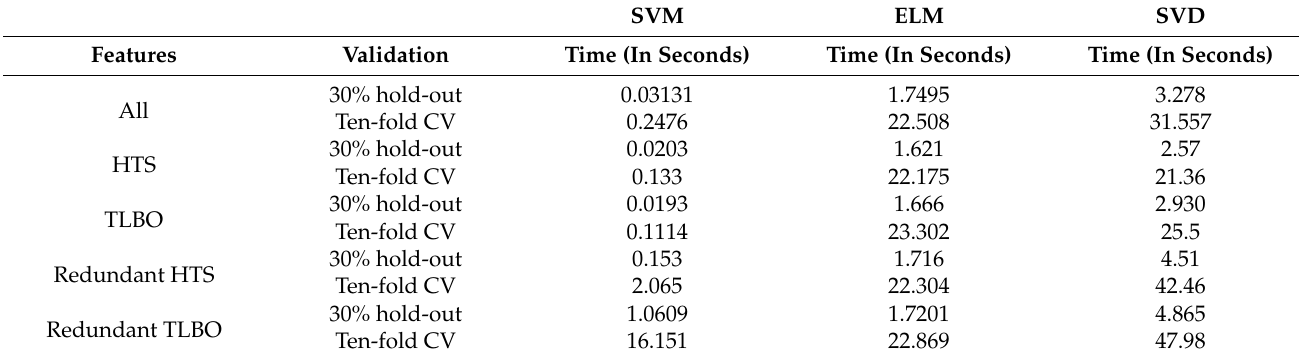
Table 7. Computational